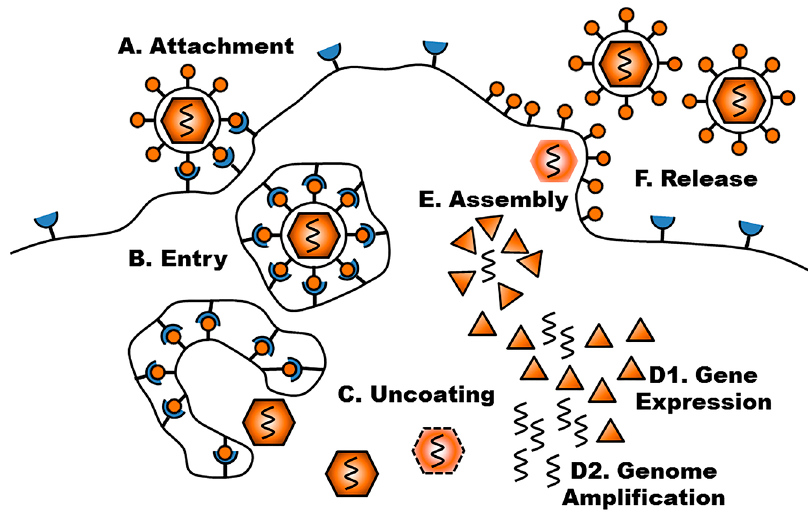
Figure 1. Schematic representation of the reproductive cycle of viruses. After successful attachment to a cell entry receptor ( A ), entry via membrane fusion or endocytosis ( B ), and uncoating of nucleic acids ( C ), viral gene expression ( D1 ) and genome amplification ( D2 ) are initiated. These processes can be complex and may include reverse transcription of the genome, shuttling to the nucleus, and further processing and modification of generated nucleic acids and proteins. Assembly ( E ) and subsequent release ( F ) of viral progeny complete the viral “life cycle”. Each of these steps contributes to (tumor) cell specificity of a particular virus as well as its replicative and cytolytic potential and, depending on the scientific question, may need to be considered in mathematical modeling.